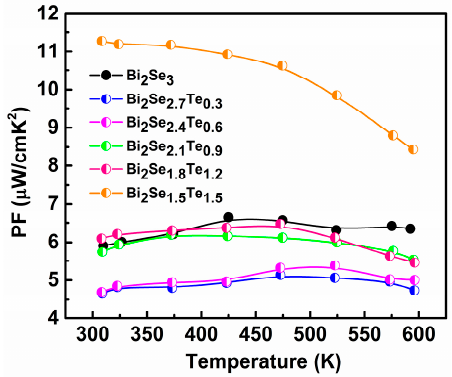
Figure 3. The temperature dependence of power factor for Bi 2 Se 3 − x Te x samples.